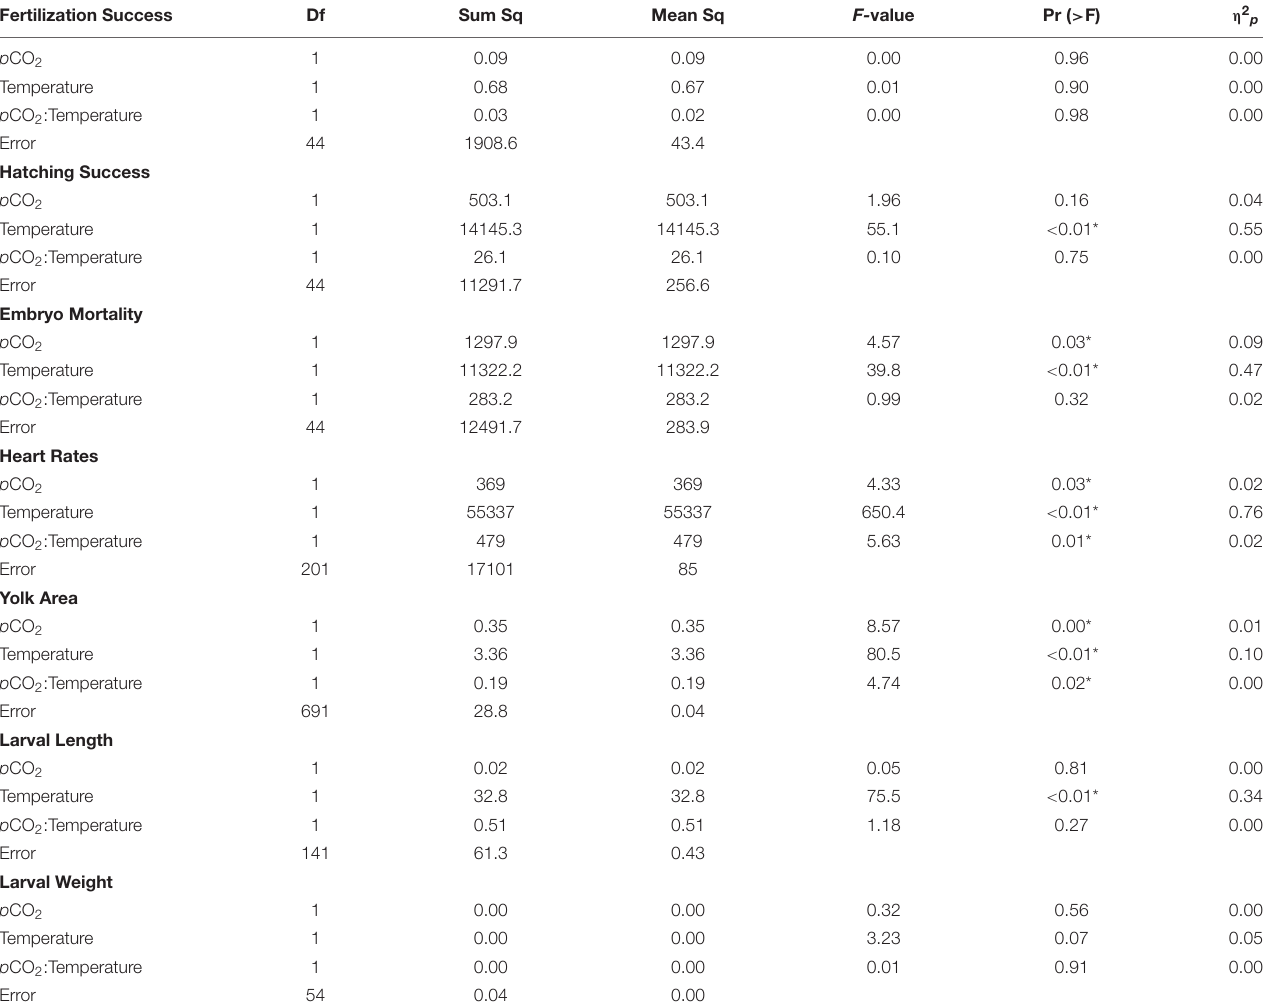
TABLE 2 | Two-way analysis of variance of each measured parameter (in bold) of Pacific herring early life stages as a function of temperature and p CO 2 . Fertilization